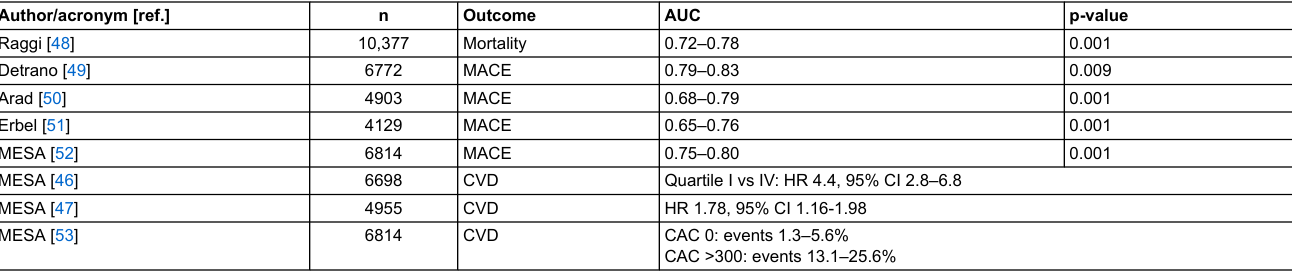
Table 2b: Major outcome studies using coronary artery calcification. Author/acronym [ref.]